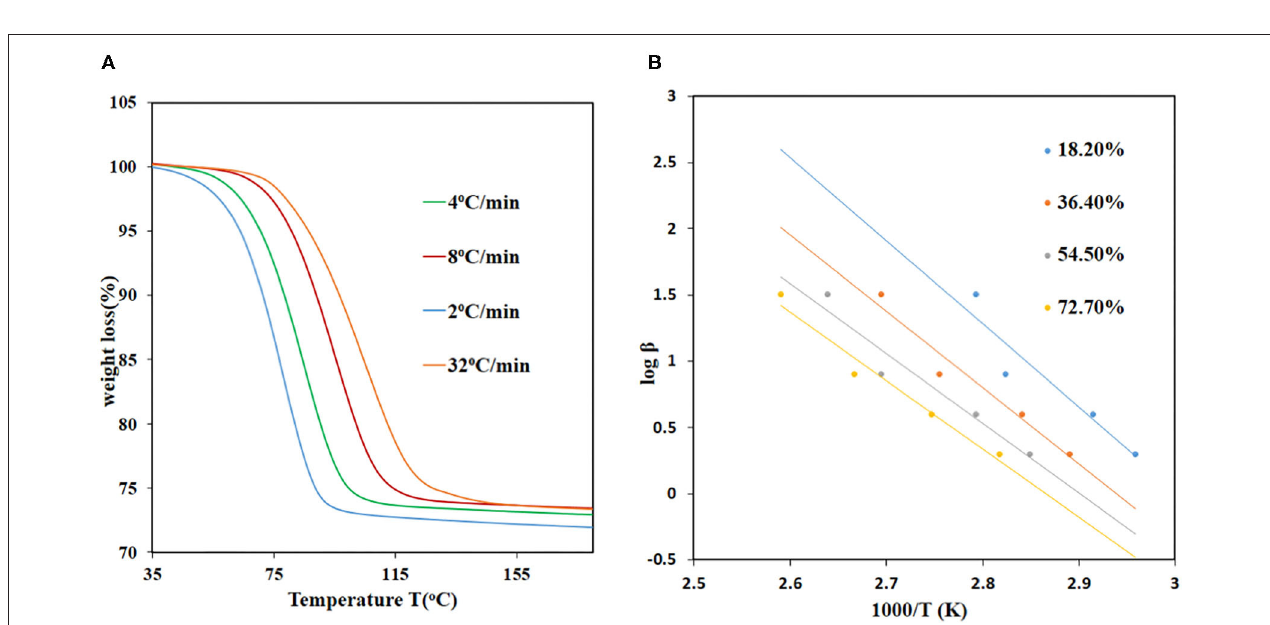
FIGURE 8 | Desorption kinetics for JMS-4: (A) TGA traces obtained using different heating rates as a function of temperature, (B) log β vs. 1/T, the gradient of the slope were used to calculate the activation energies.